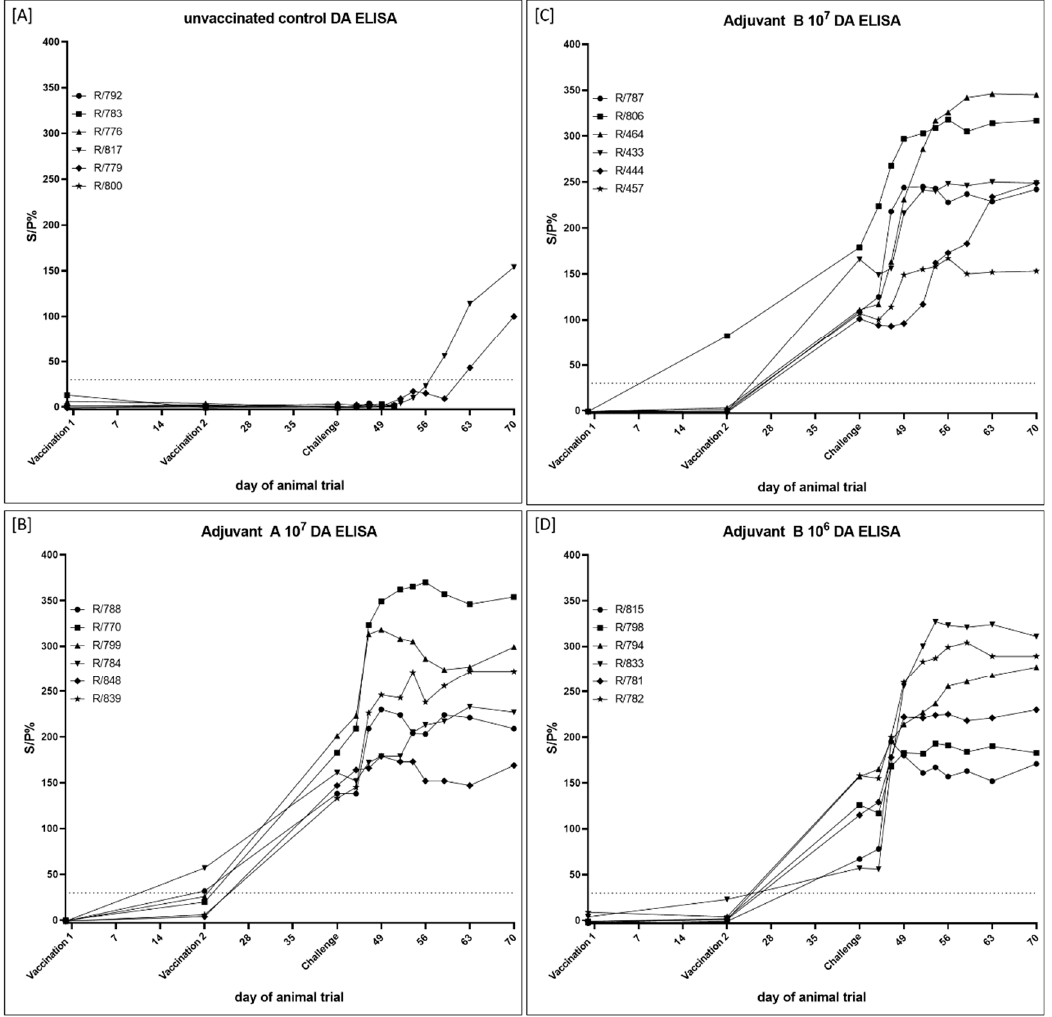
Figure 12. Serological examination of the sera taken during the vaccine-efficacy study using the DA ELISA. ( A ) Cattle of Group 2A serve as mock-control and received PBS. Animals of the other groups were immunized with inactivated LSDV-“Serbia” field strain using different adjuvants and virus titers before inactivation. ( B ) Cattle of Group 2B were vaccinated with Adjuvant A 10 7 , ( C ) cattle of Group 2C received Adjuvant B 10 7 , and ( D ) animals of Group 2D were immunized with Adjuvant B 10 6 prototype vaccine. Samples were defined positive at an S/P% ratio ≥ 30.